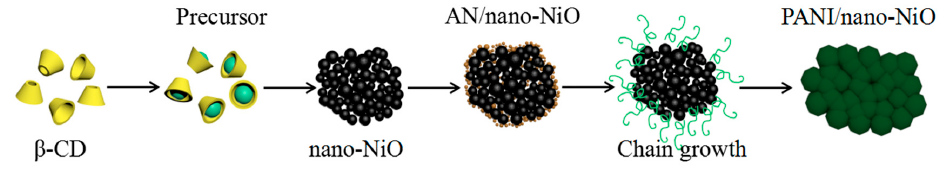
Figure 1. Mimic diagram of synthesis.